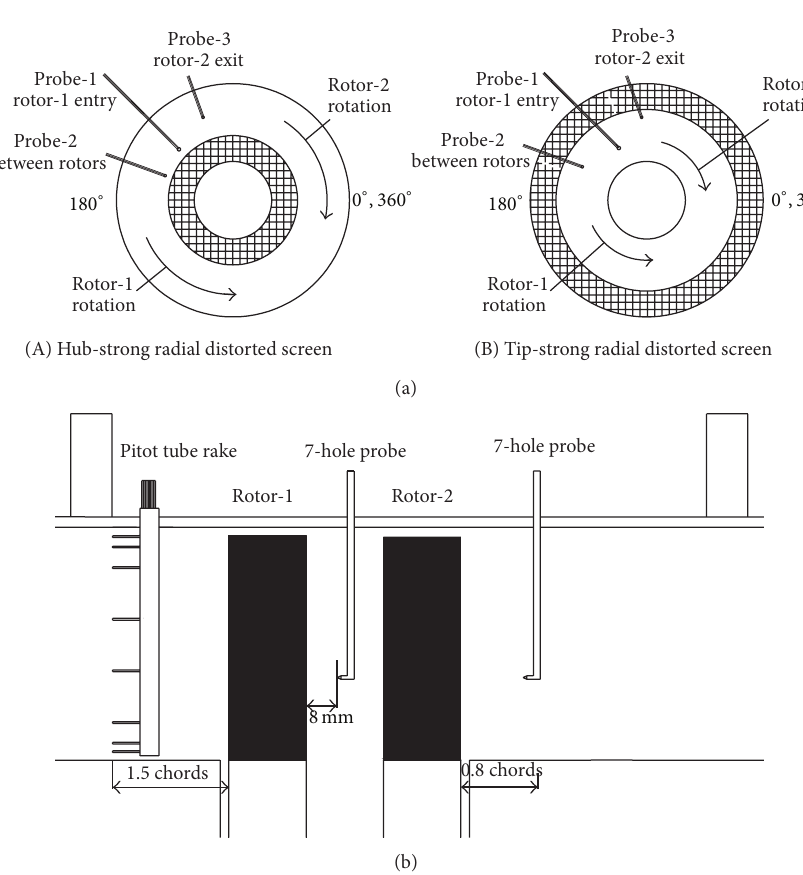
Figure 2: Schematic layout of the (a) distortion configurations and (b) probe